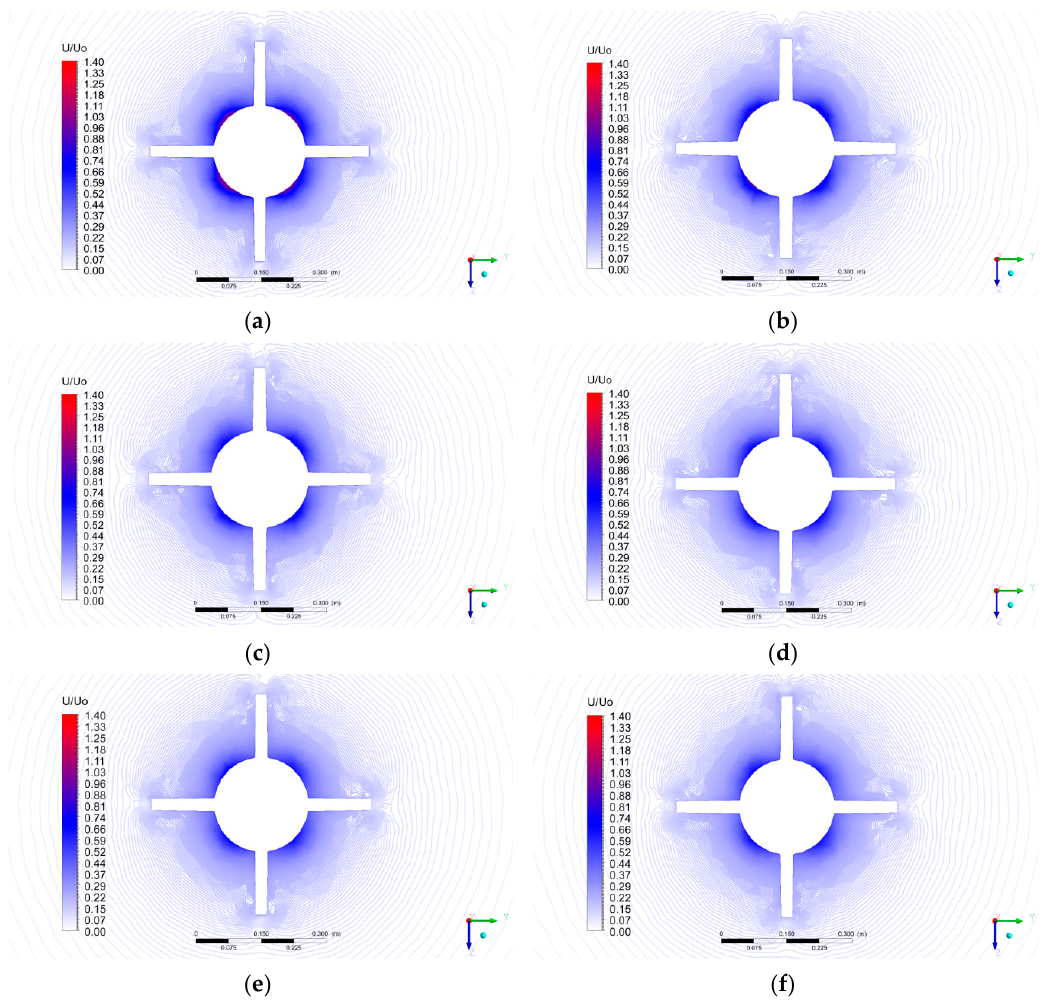
Figure 11. The normalized velocity contours around the cross-section of the rudder at x / L = 0.896 of the SUBOFF model under towing speeds of ( a ) 3.05 m / s; ( b ) 5.144 m / s; ( c ) 6.096 m / s; ( d ) 7.16 m / s; ( e ) 8.23 m / s; and ( f ) 9.151 m / s at t = 30 s.